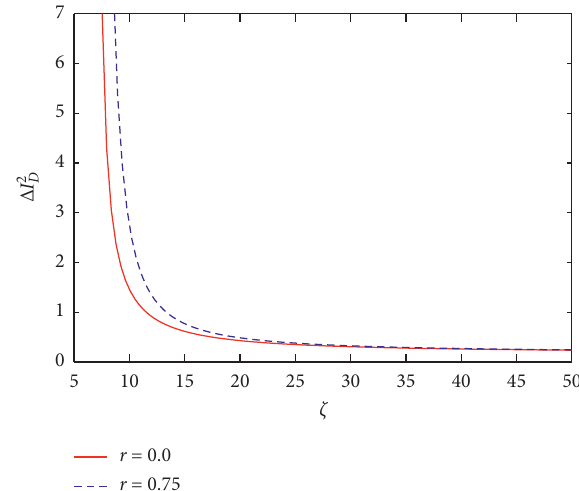
Figure 11: Plots of the steady state intensity difference fluctuation (equation (64)) versus ζ for κ � 0 . 8, ε � 0 . 20, and A � 2 . 50 and for different values of r